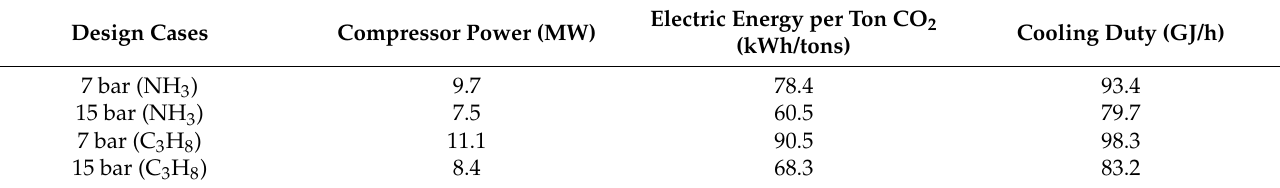
Figure 10. Heat curve for the heat exchanger. Hot composite/CO 2 stream (red) and cold composite/NH 3 (blue).